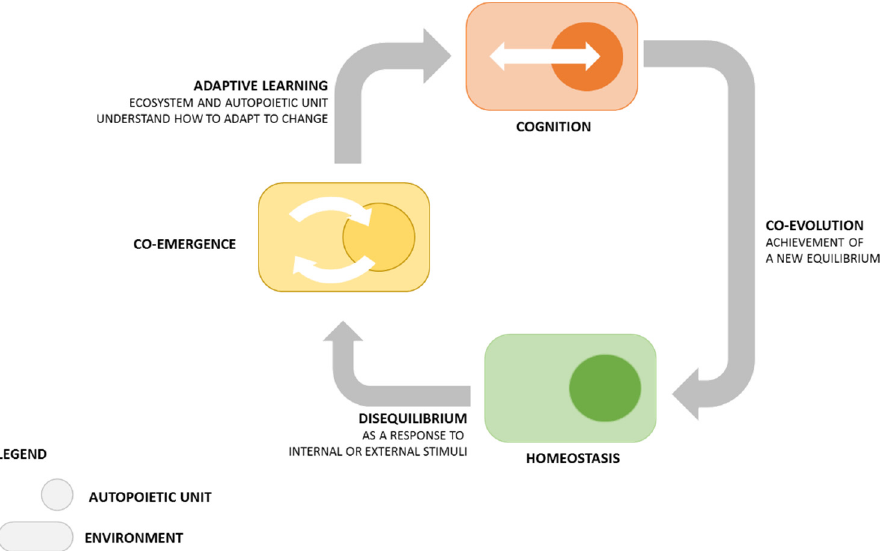
Figure 1. An autopoietic unit (living system) interacts with its environment (ecosystem) to maintain an equilibrium (homeostasis); hence, they organize each other by giving and interpreting reciprocal feedbacks (chemical, cognitive, etc.). While interacting (conceived of as a flow of stimuli), systems and ecosystems maintain their endogenous autonomy that differentiate them hierarchically and functionally. When a loss of balance is due to internal/external stimuli, the result of their interaction is a co-emergence of information because both parties need to re-establish their equilibrium. In order to achieve a new homeostasis, system and ecosystem must co-adapt to change intended as a learning experience. Once they “understand” how to reach a new balance (cognition), they co- evolve and therefore achieve a novel homeostasis. Because life itself is a continuous process between disequilibrium and homeostasis, Maturana and Varela draw the conclusion that “living is knowing and knowing is living” [16]. See also